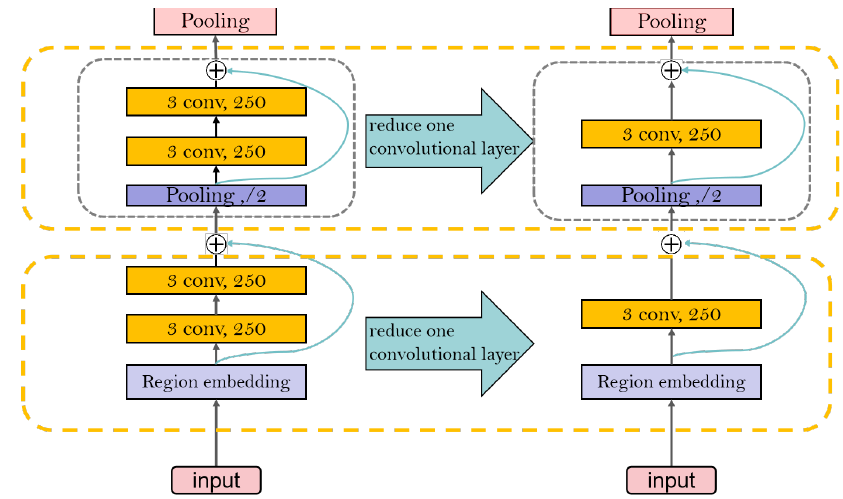
Figure 6. Comparison between DPCNN and DPCNN-upgrade structures.